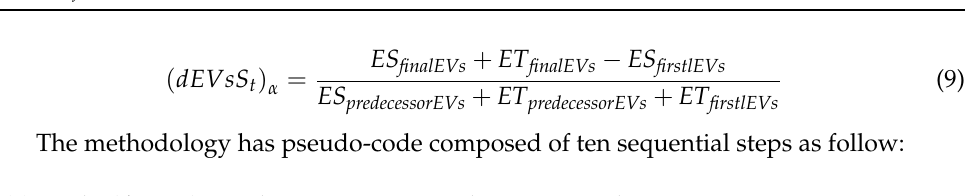
Table 4. The ( dEVsS t ) pseudo steps to construct the DQ